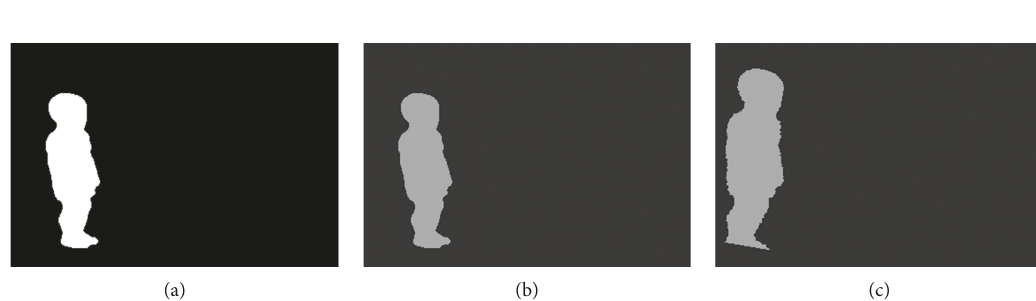
Figure 1: Shape prior and synthetic clean images. The left image: shape prior. The middle image: clean image without affine transformation. The right image: clean image with affine